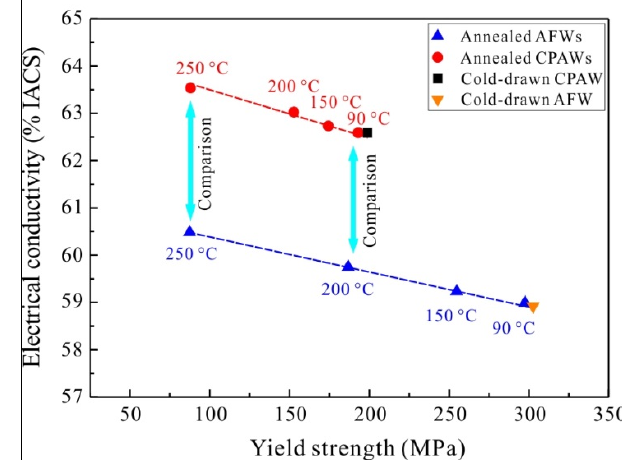
Figure 2. The yield strength and the electrical conductivity of the commercially pure Al wires (CPAWs) and the Al-Fe wires (AFWs).